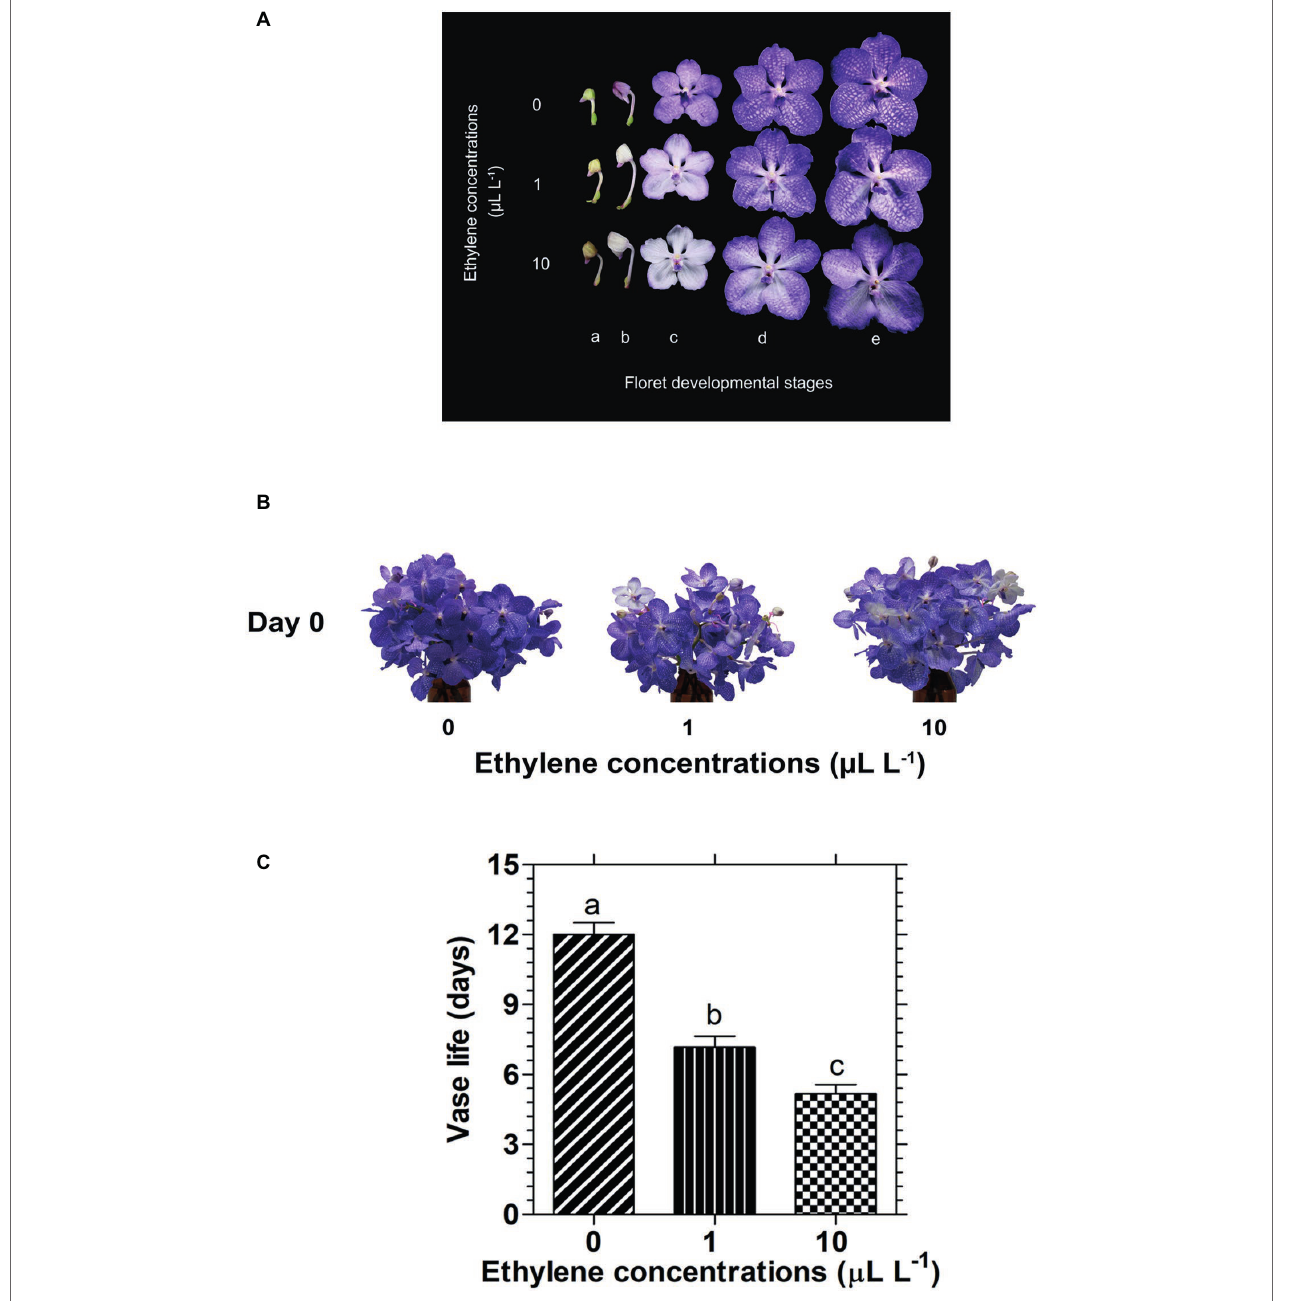
FIGURE 1 | Effect of exposure of cut Vanda ‘Sansai Blue’ flowers to different ethylene concentrations on the visual appearance of florets at various developmental stages (A) , on the visual appearance of cut inflorescences photographed immediately after removal from the ethylene environment (day 0) (B) , and on their vase life longevity (C) . The inflorescences were exposed to 0 (control), 1, or 10 μl L −1 ethylene for 24 h at 21 ± 2 ° C, and then placed in the observation room. The different floret developmental stages were defined as follows: a, tight bud; b, colored bud; c, half bloom; d, bloom; e, full bloom. The results in graph (C) represent means ± SE of 6–8 inflorescence replicates per treatment. Different letters indicate significant differences at p <